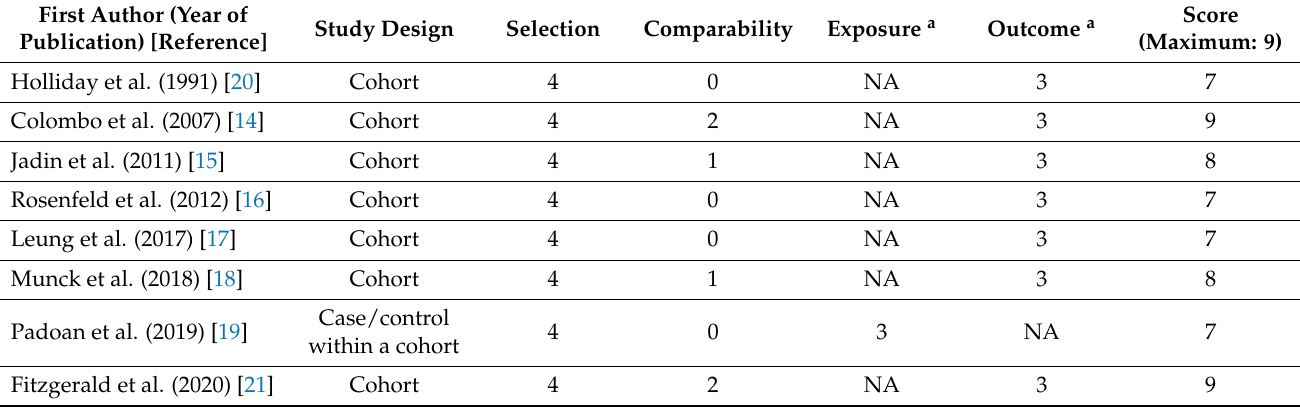
Table 2. Risk of bias for the included case–control and cohort studies according to the Newcastle–Ottawa scale.